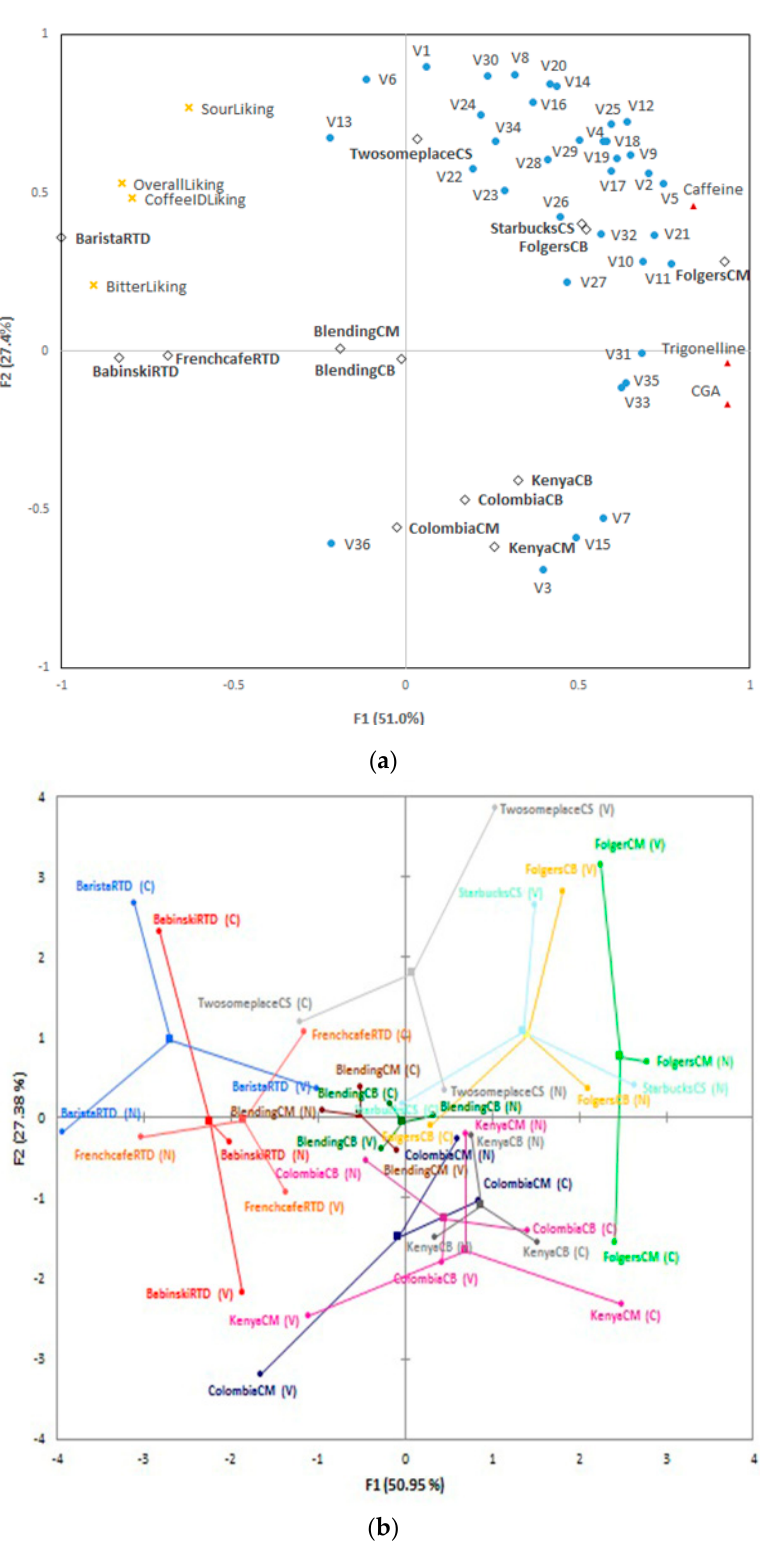
Figure 4. Multi-factor analysis of instrumental and sensory data ( a ) and superimposed map of coffee samples ( b ). (C), (N), and (V) stands for consumer acceptability, non-volatiles compounds, and volatile compounds, respectively.